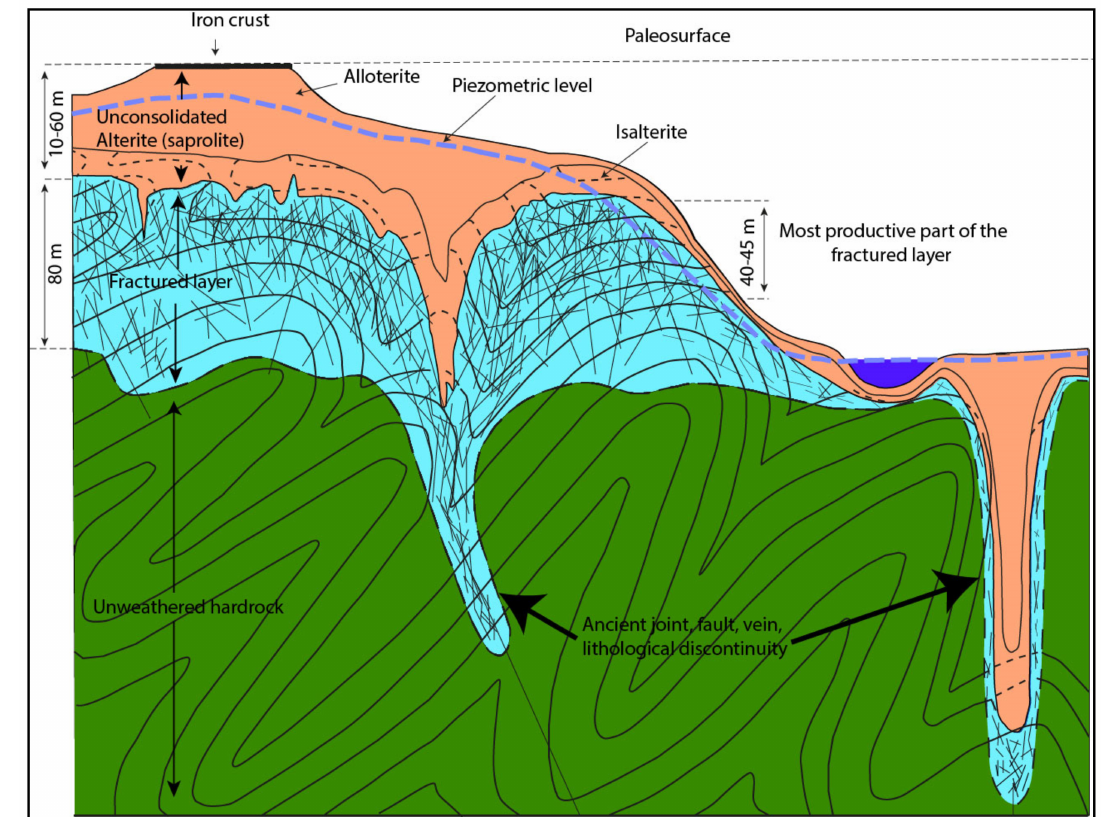
Figure 14. Conceptual model of the hard rock aquifers weathering profile in metamorphic rocks in the Montagnes District of C ô te d’Ivoire (from [26],